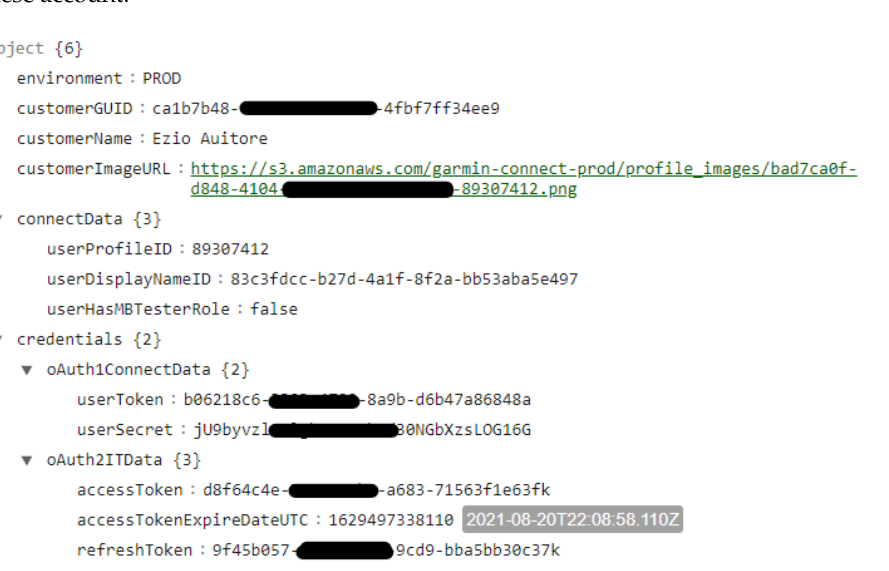
Figure 15. Redacted data about the currently signed in account for the Garmin Connect user, taken from the mobile.auth.xml file.